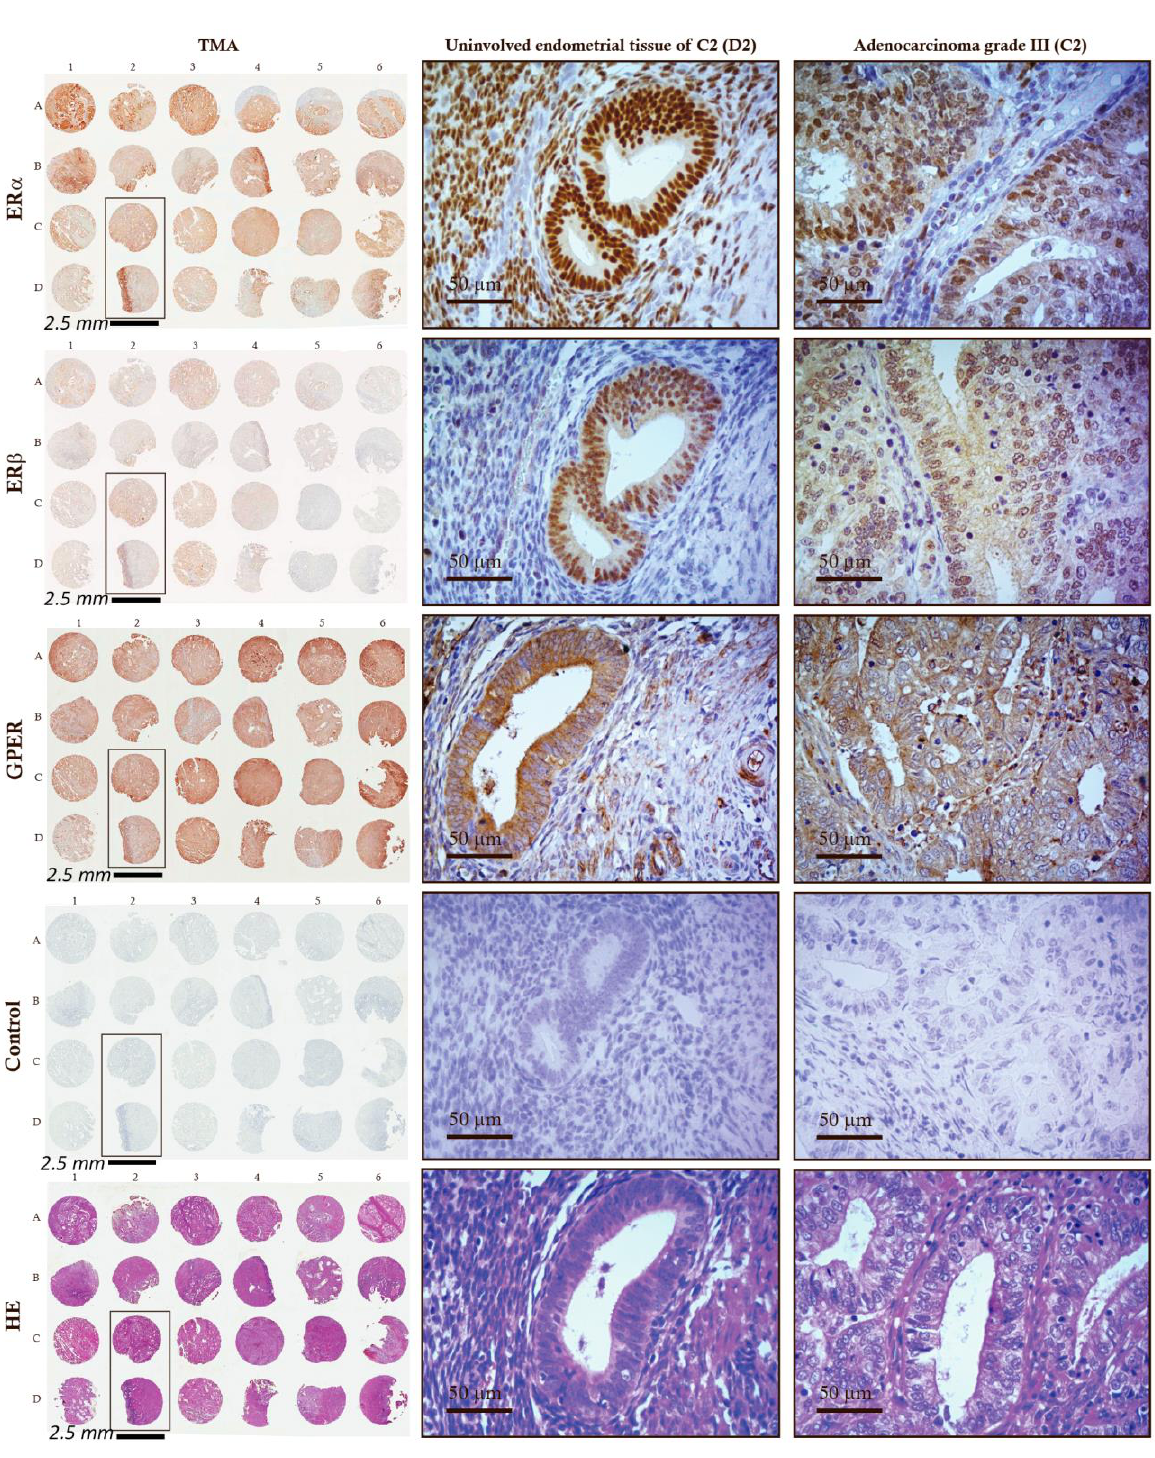
Figure 7. Co-expression of ER α , ER β , and GPER in EC tissue cores of the tissue microarrays. Positions of samples in tissue microarrays are marked by letters A–D and numbers 1–6. The whole TMAs and control endometrial tissue (D2) and EC tissue (C2) cores are shown for ER α (anti-ER α antibodies, 1D5 Dako, Cat. #: M7047, lot 1: 00034057, lot 2: 20015818), ER β (anti-ER β antibodies, 14C8, GeneTex, Cat. #: GTX70174, Lot: 20882), and GPER (anti-GPER antibodies, HPA027052, Sigma-Aldrich, Cat. #:HPA027052, Lot: A61748) staining. The control staining was carried out without the primary antibodies. Sections were also stained with hematoxylin and eosin (HE). Scale bar, 50 µm.